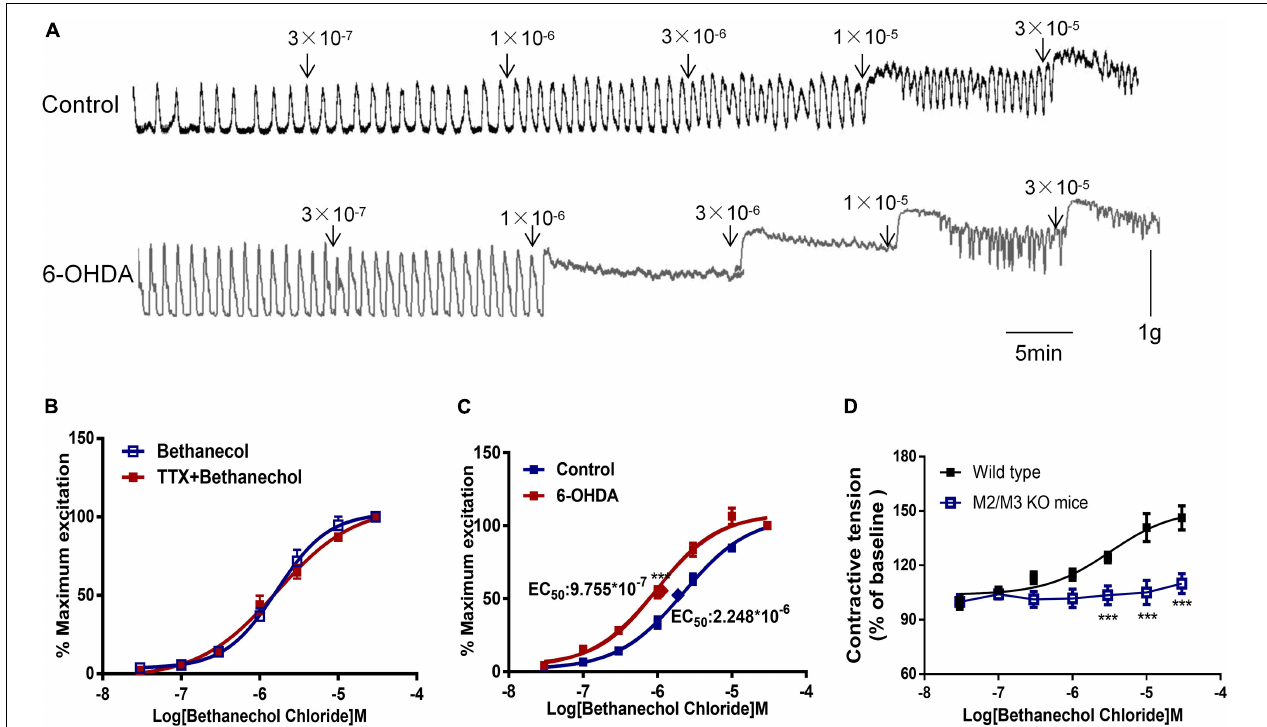
FIGURE 3 | Effect of bethanechol chloride on colorectal contraction. (A) Representative recordings show the effect of bethanechol chloride on colorectal muscle strips from control and 6-OHDA rats. (B) Concentration response curve of bethanechol chloride alone and in the presence of TTX (1 µ M) in control rats ( n = 6). (C) Dose-response curve of bethanechol chloride in the colorectum of control and 6-OHDA rats ( n = 6). (D) Concentration-response curve of bethanechol chloride in M 2 R and M 3 R knockout (KO) mice ( n = 5). (B–D) Two strips per rat. *** P <